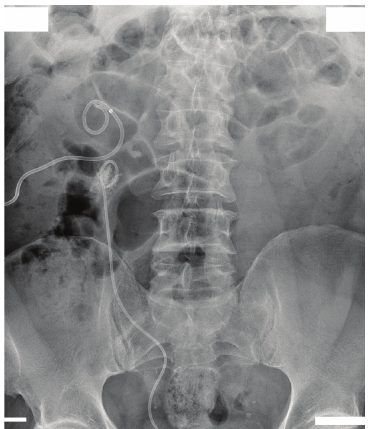
Figure 5: Plain X-ray image of the urinary tract after the semirigid ureterorenoscopyprocedureshowsthatalmosthalfofthemeshstent and its incrustations were completely disintegrated by laser energy.